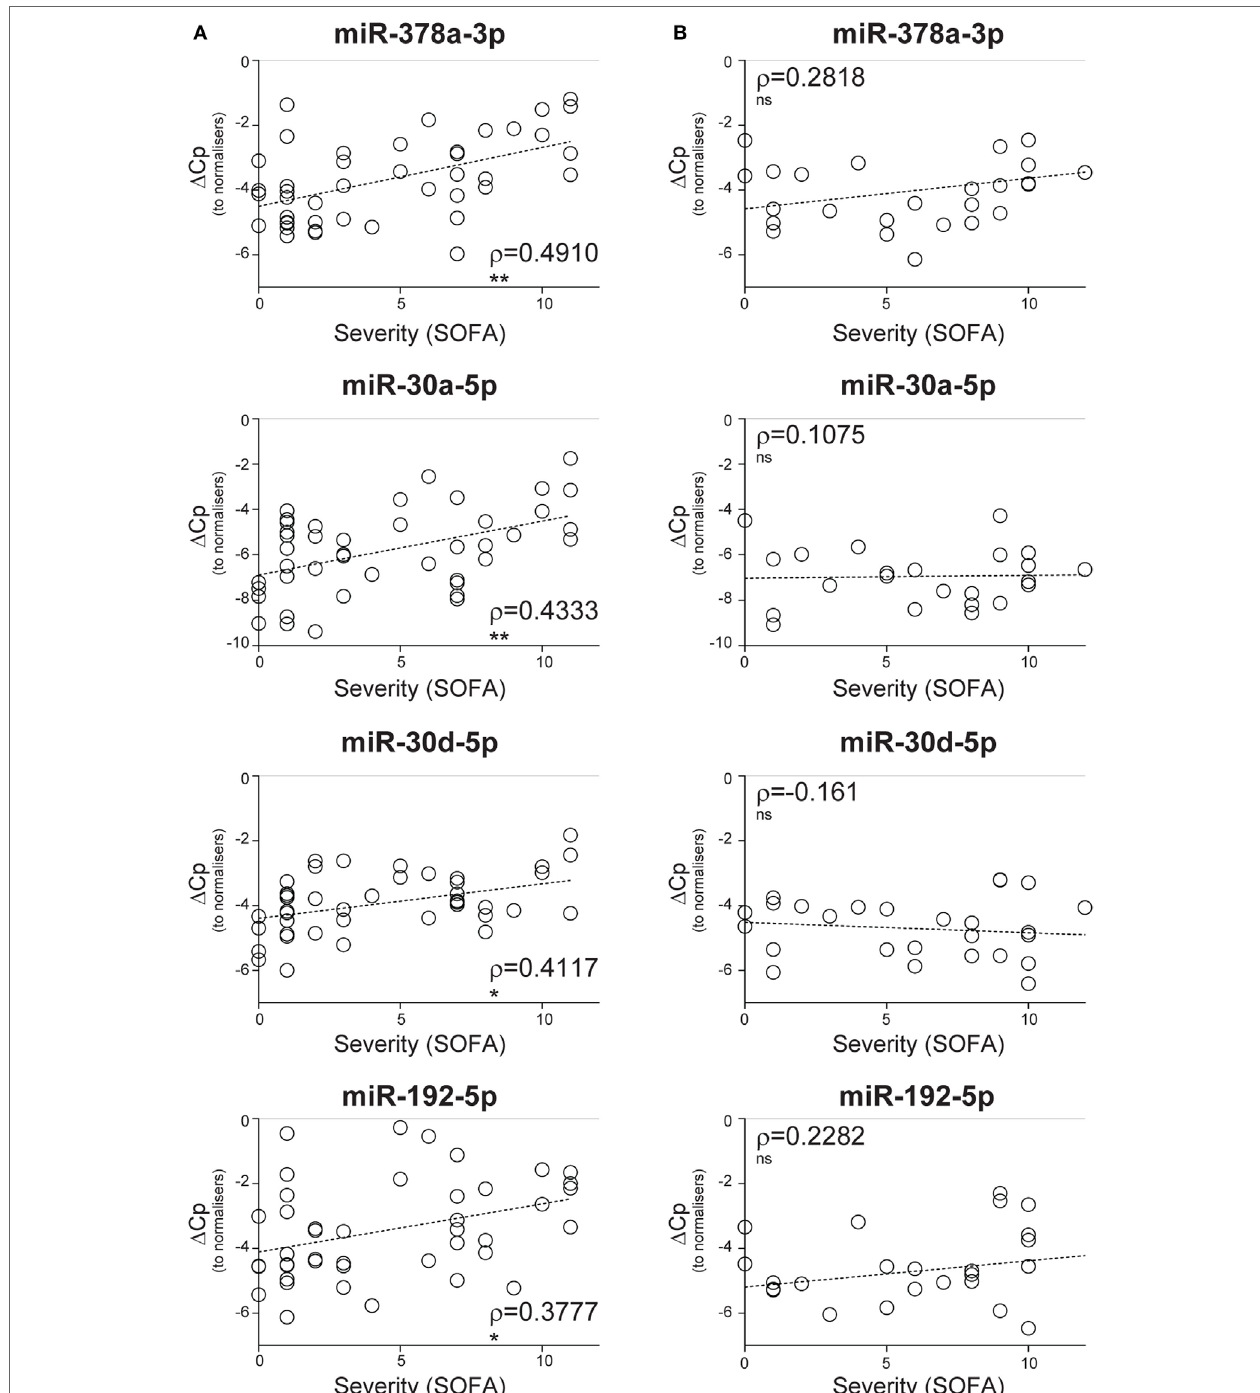
FigUre 1 | Circulating inflammatory-relevant microRNA levels correlate with the severity of non-infective systemic inflammatory response syndrome (SIRS). In miRNA qPCR arrays, within each patient’s specimen, crossing point (Cp) of a single miRNA is compared to the mean Cp of 2 normalizers (miR-486-5p and miR-320a) to give delta Cp (dCp). dCp of non-infective SIRS (a) and sepsis (B) patients were analyzed in correlation analyses with disease severity, as determined by the sequential organ failure assessment (SOFA) score. (a) Non-parametric correlation of SOFA scores with the plasma levels of miR-378a-3p, miR-30a-5p, miR-30d-5p, and miR-192-5p in non-infective SIRS patients ( n = 43 for all miRNAs). (B) Non-parametric correlation of SOFA scores with the plasma levels of miR-378a-3p ( n = 26), miR-30a-5p ( n = 24), miR-30d-5p ( n = 27), and miR-192-5p ( n = 27) in infective SIRS (sepsis) patients. Each symbol represents an individual patient. Correlation trends are shown with the linear regression model including Spearman rho ( ρ ) and the significances of the correlations (* p ≤ 0.05; ** p ≤ 0.005; and *** p ≤ 0.0005 or ns,